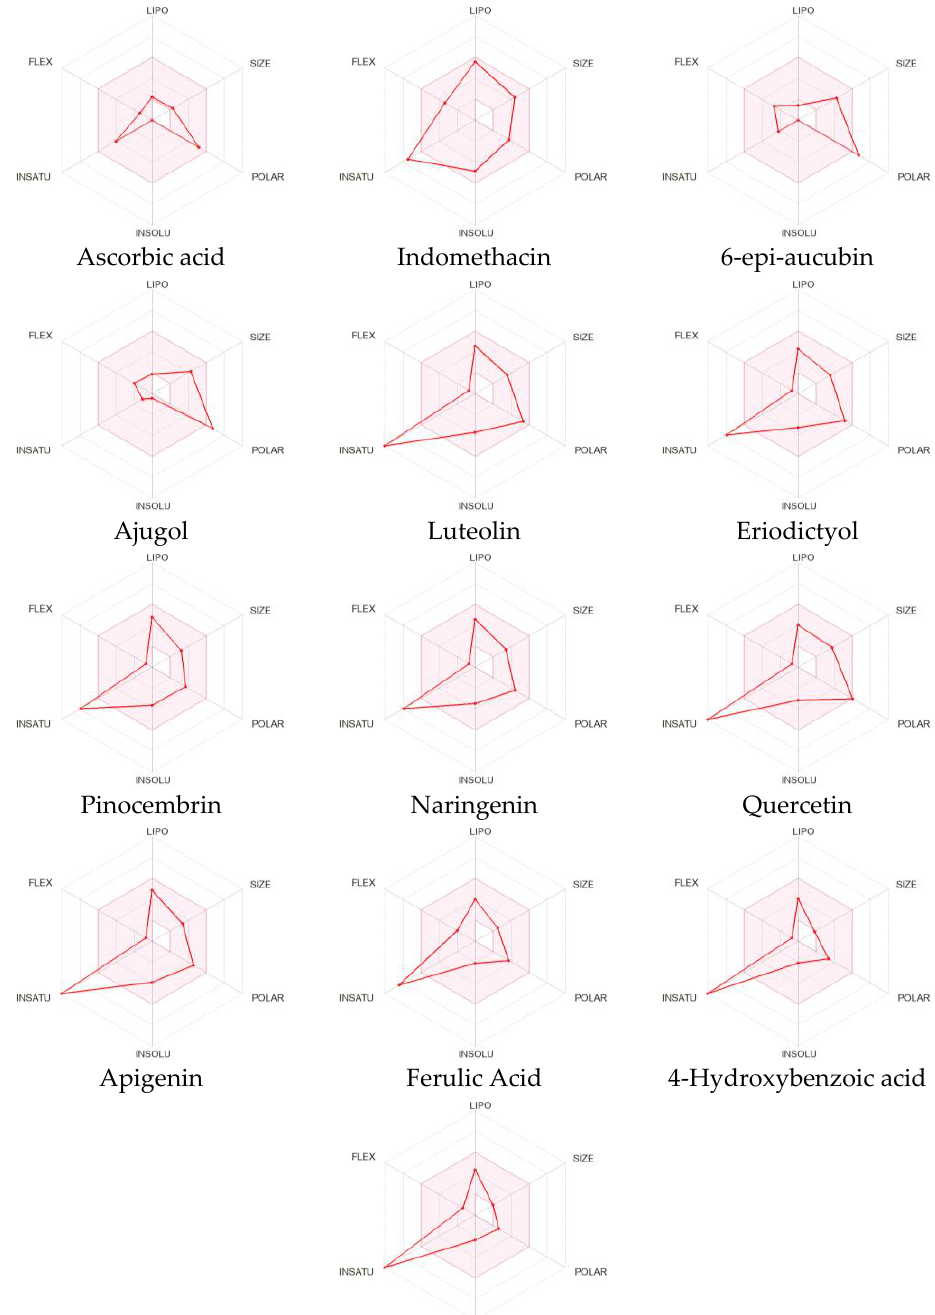
Figure 1. SwissADME bioavailability radar for drug-likeness of all identified compounds from Crescentia cujete , indomethacin and ascorbic acid.